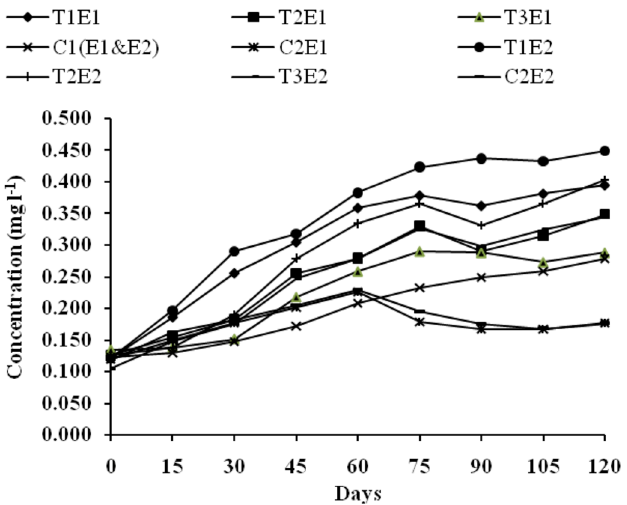
Fig. 4. Temporal changes in NO 3 -N ofwaterin all the treatments of E1 and E2.